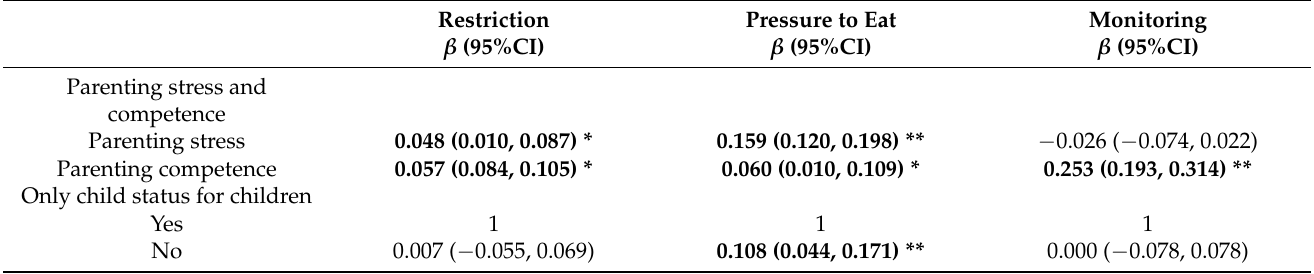
Table 4. Linear regression relationships between family characteristics and feeding